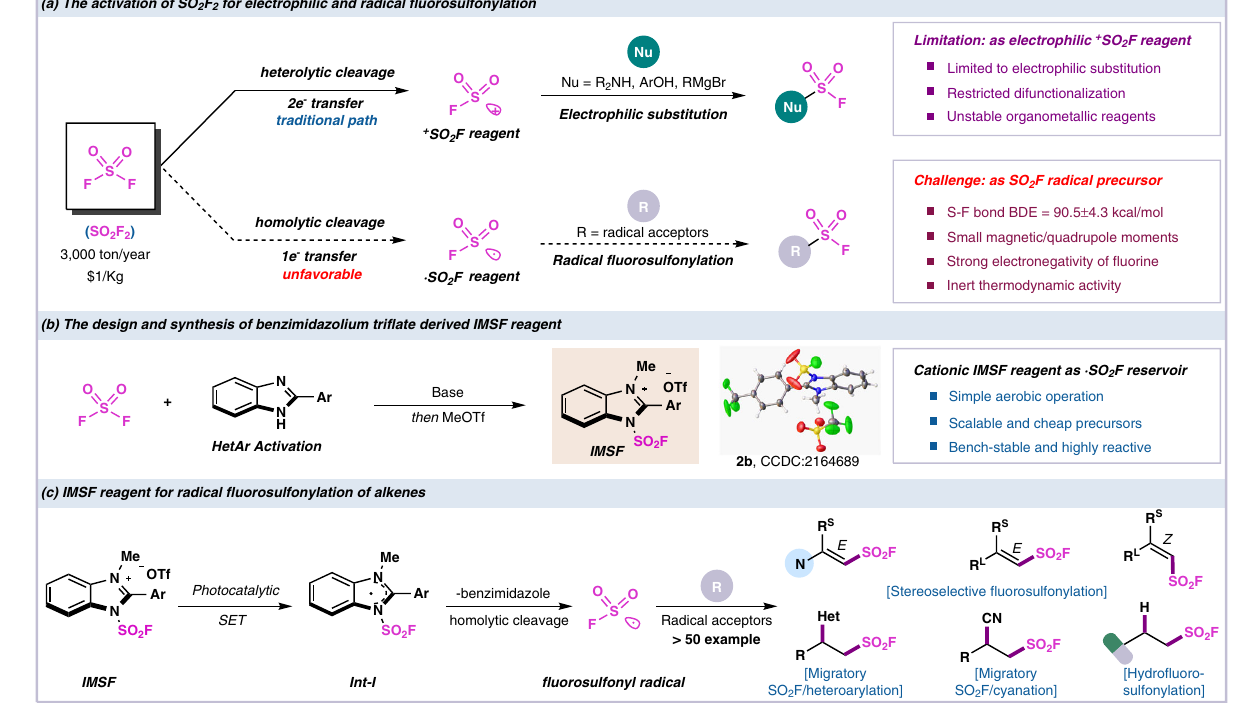
Fig. 1 Origin of the reaction design. a The activation of SO 2 F 2 for electrophilic and radical fl uorosulfonylation. b The design and synthesis of benzimidazolium tri fl ate derived IMSF reagent. c This chemistry: Cationic IMSF reagent for radical fl uorosulfonylation of alkenes.